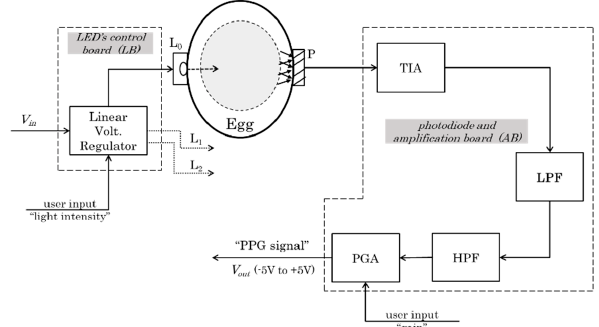
Figure 1. Main hardware components of the developed prototype (Egg-PPG) shows the LED control circuit board ( LB ) for the infrared LEDs ( L 0 , L 1 , and L 2 ), photodiode ( P ), and the photodiode and amplification circuit board ( AB ) includes a transimpedance amplifier ( TIA ), low-pass filter ( LPF ), high-pass filter ( HPF ), and programmable gain amplifier ( PGA ).